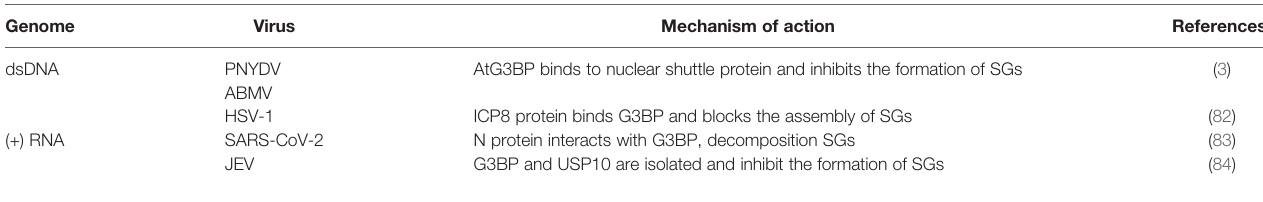
TABLE 2 | Virus Inhibits the formation of